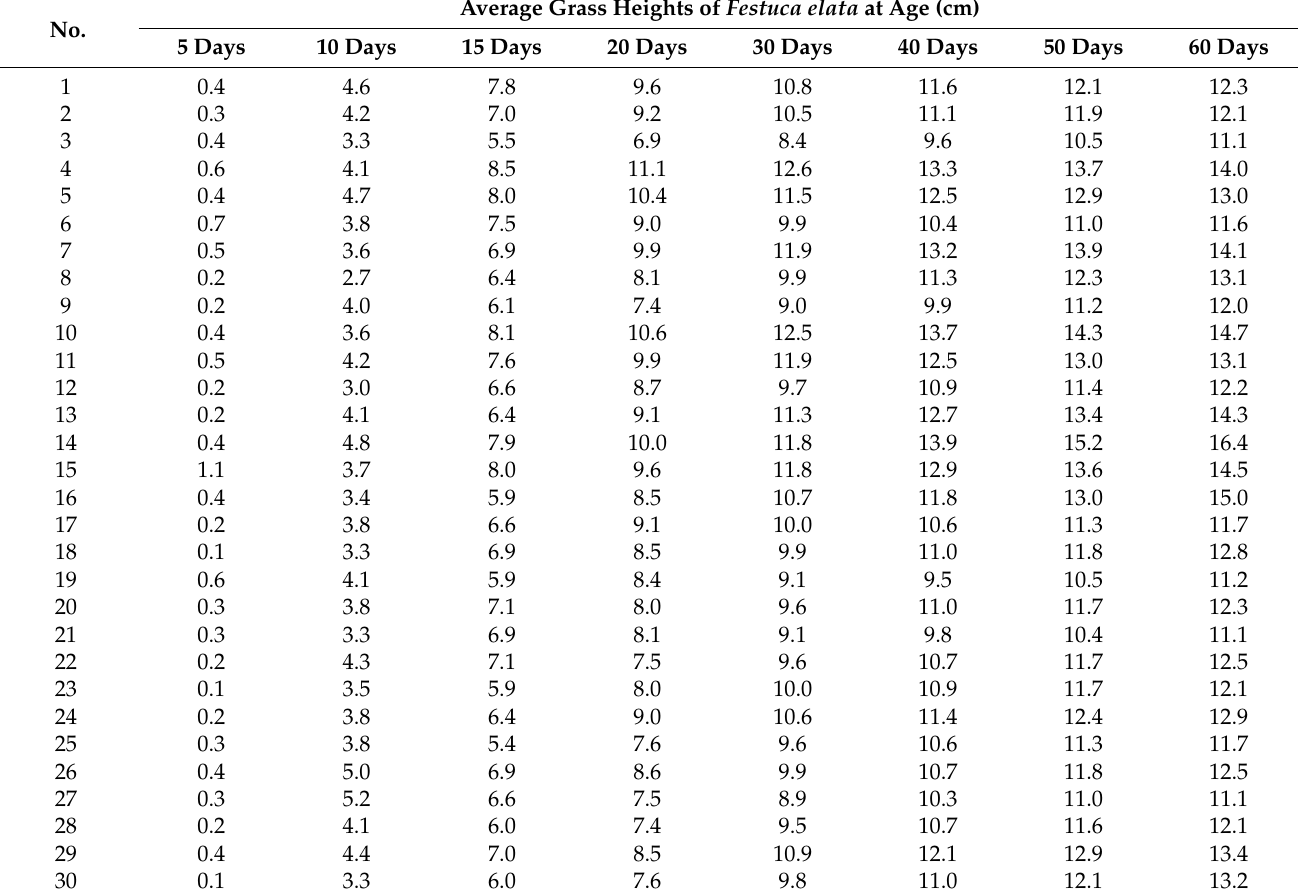
Table 5. Average grass heights of Festuca elata